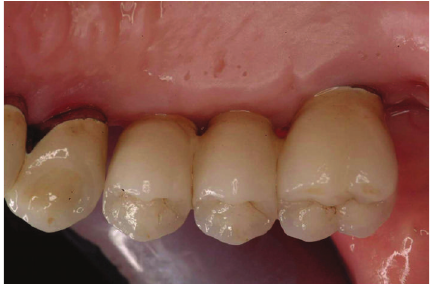
Figure 39: Adequate plaque control, low inflammatory indices, and physiologicprobingrangingfrom1to4mmaroundalltheabutment teeth and implants were recorded at the end of treatment.